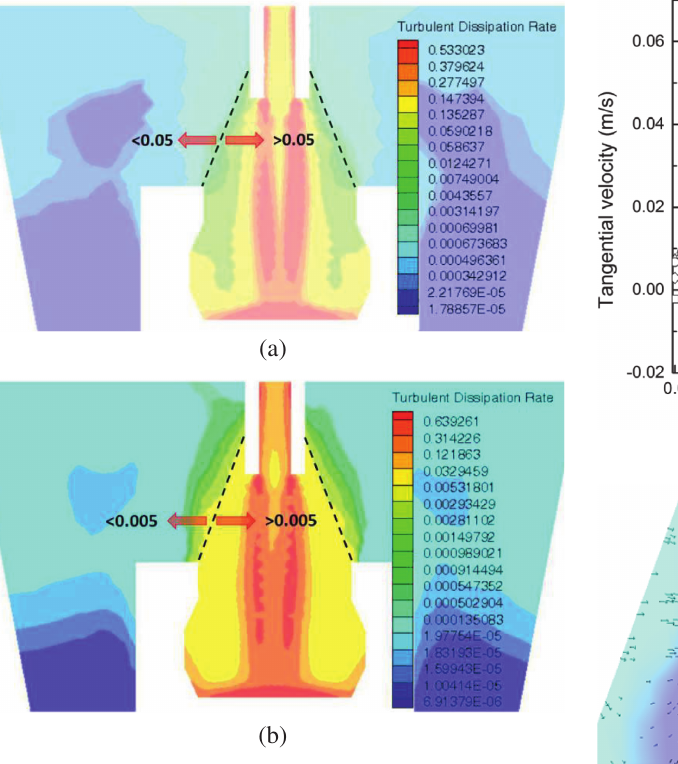
Figure 8: The contour of turbulent dissipation rate in impact zone of tundish with ISTTC. (a) tundish with tradition TI (b) tundish with ISTTC.